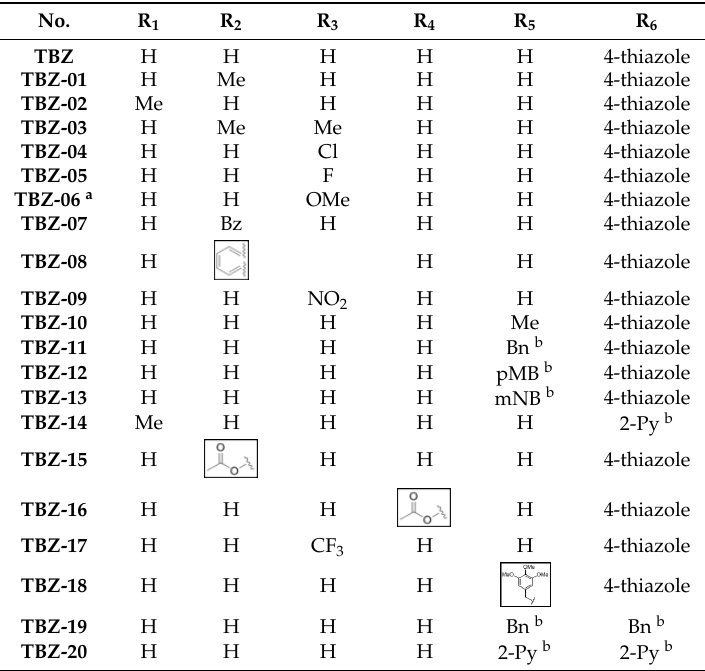
Table 1. Structures of TBZ Table 1. Structures of TBZ derivatives. Table 1. Structures of TBZ derivatives. Table 1. Structures of TBZ derivatives. Table 1. Structures of TBZ derivatives. Table 1. Structures of TBZ derivatives.